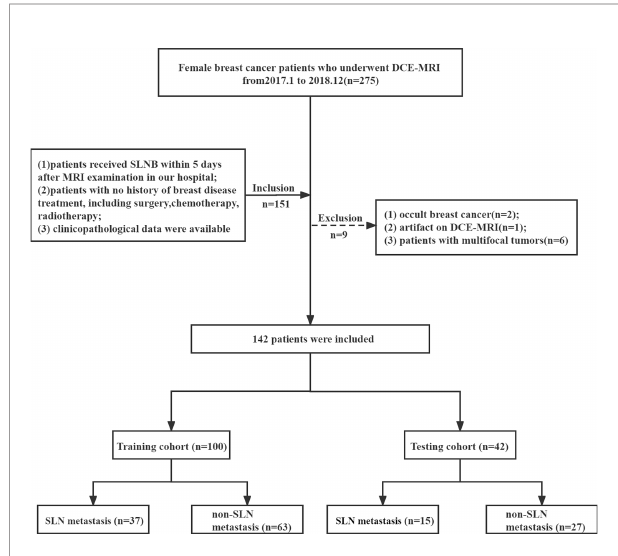
FIGURE 1 | Flowchart of patient